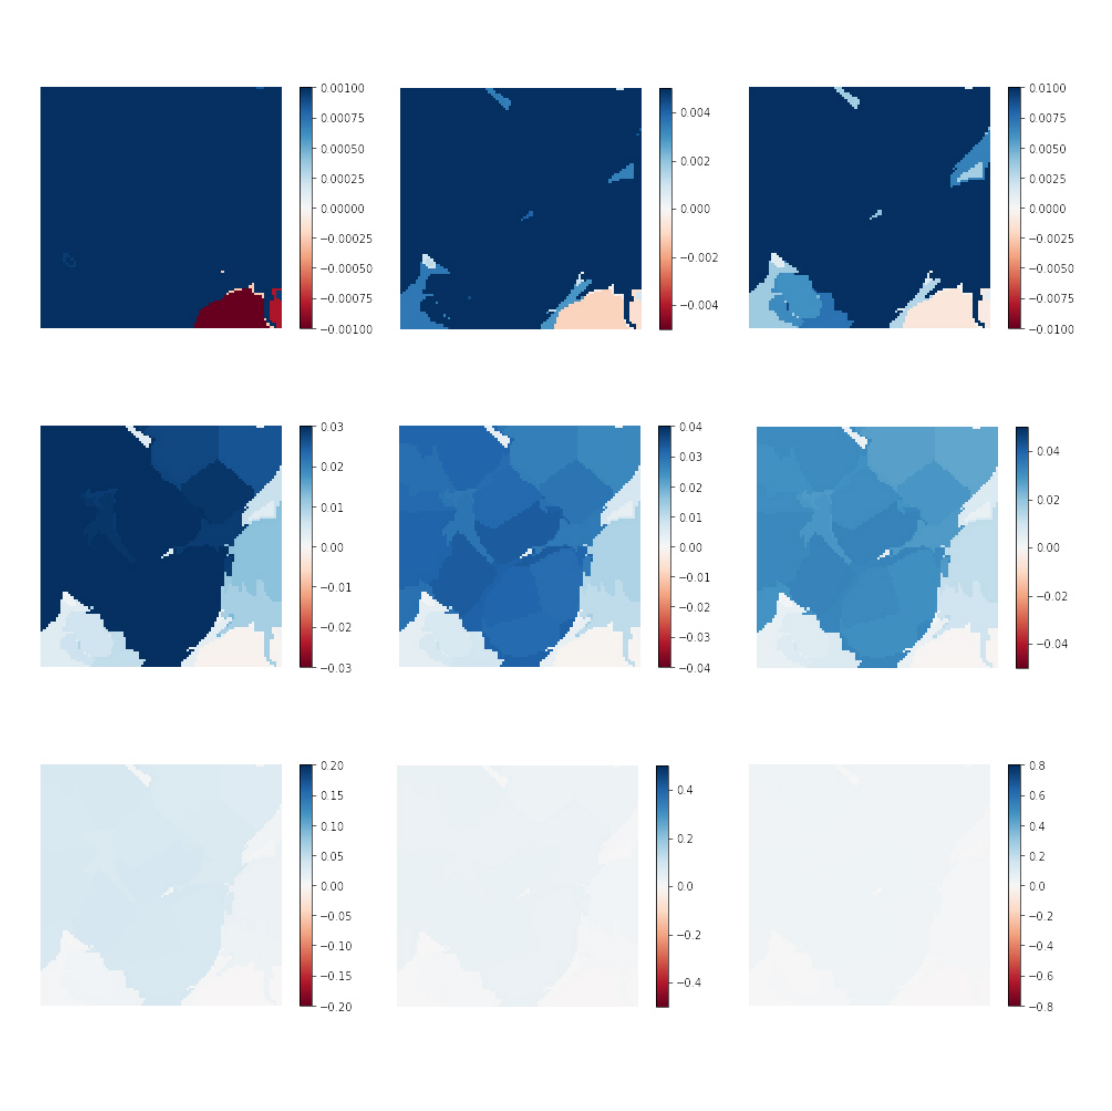
Figure 8. Heat map of Row j, Figure 6, replotted several times with color scale limits varying from [ − 0.001, 0.001]–[ − 0.8,